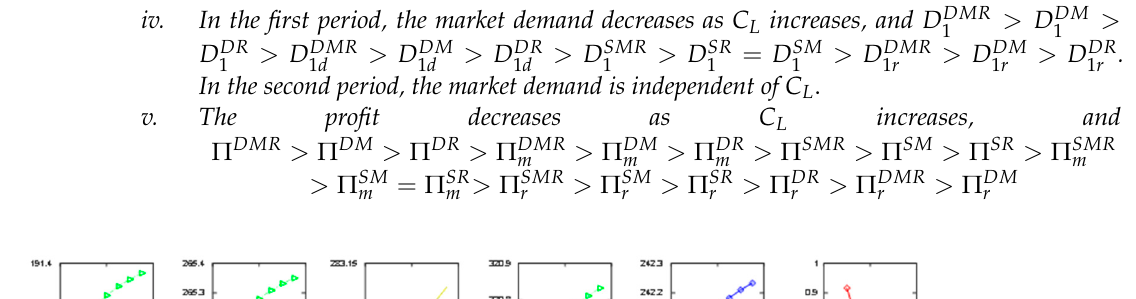
. In the second period, the wholesale price is